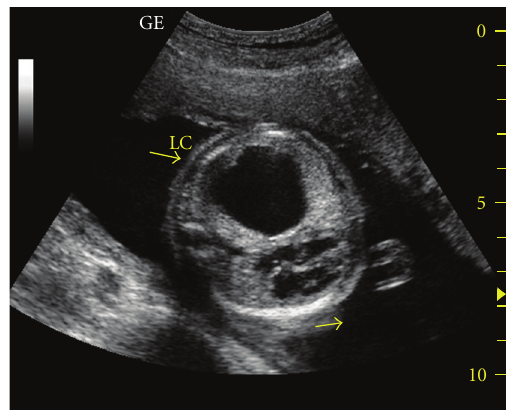
Figure 1: Sonographic examination revealed uniloculated, 40 × 37mm sized, smooth contour congenital cystic lung lesion which originated from left hemi thorax.